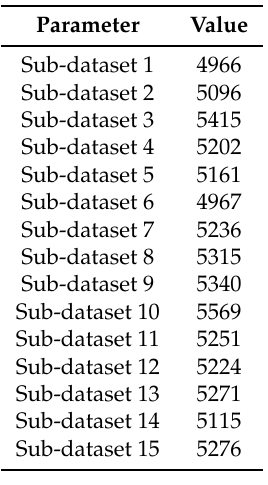
Table 1. Distribution of datasets.